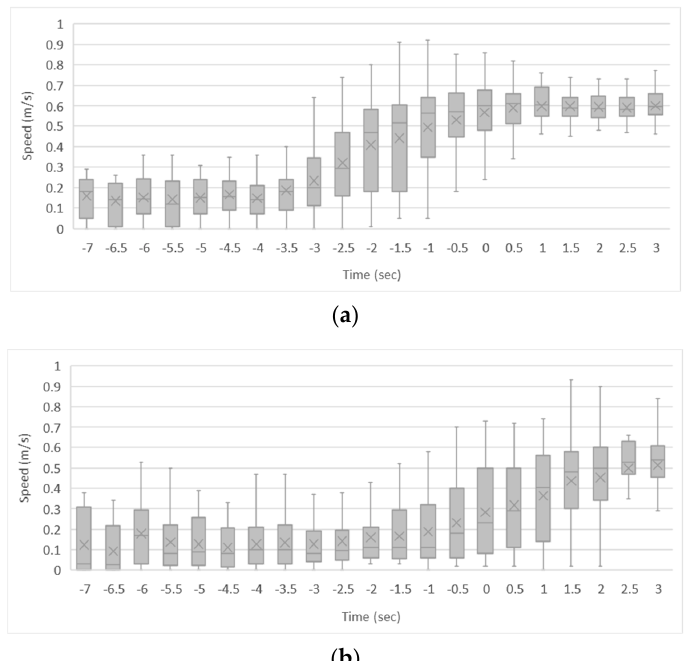
Figure 6. Pedestrian’s movement speed in Group 1 (CV) and Group 2 (AV). ( a ) Group 1. ( b ) Group 2.